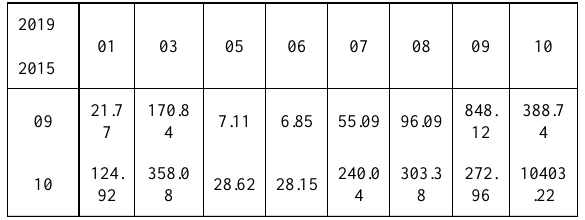
Table 2. Conversion matrix of coastal landscape change. The land type codes are detailed in Figure 1.